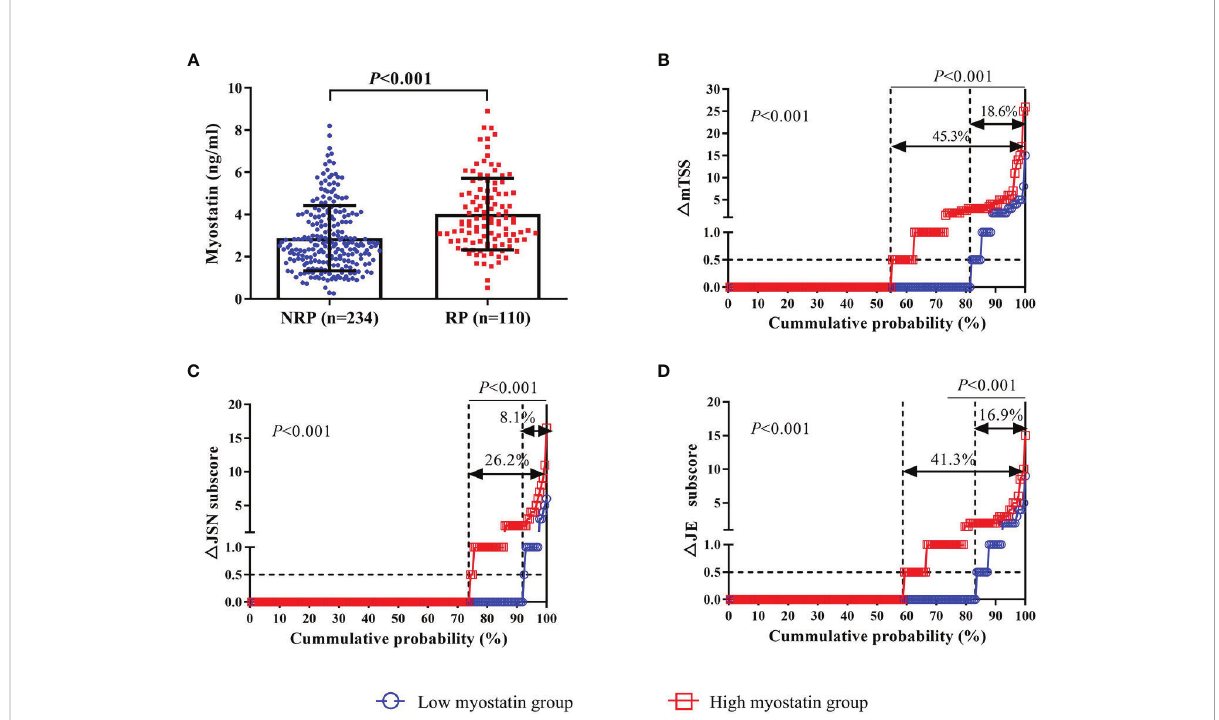
FIGURE 2 Association between baseline myostatin and one-year radiographic progression. Baseline serum myostatin level in RA patients with or without radiographic progression (A) ; The cumulative probability distribution of radiographic change including mTSS (B) , JSN subscore (C) and JE subscore (D) from baseline to 12 months in RA patients with or without radiographic progression. NRP, non-radiographic progression; RP, radiographic progression; D mTSS, a change in mTSS from baseline to 12 months; D JSN subscore, a change in joint space narrowing subscore from baseline to 12 months; D JE subscore, a change in erosion subscore from baseline to 12